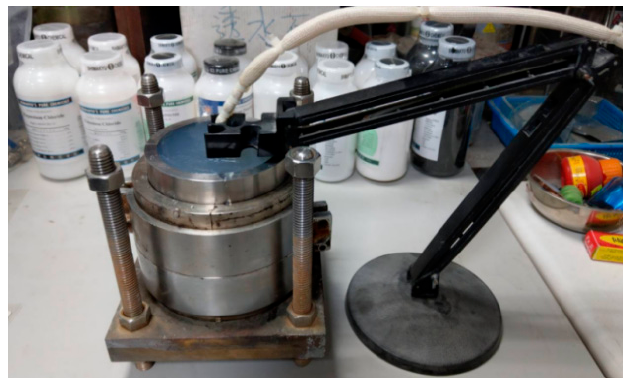
Figure 4. Calibration for the NP method.